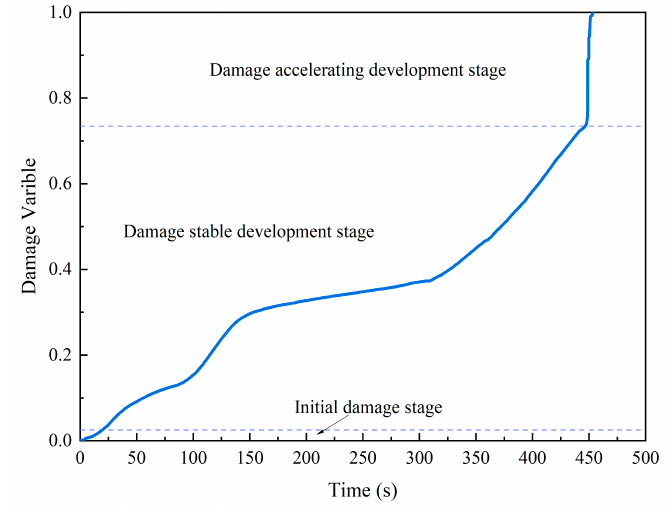
Figure 10. The curve of damage-variable time under a 30 kN dynamic normal load.